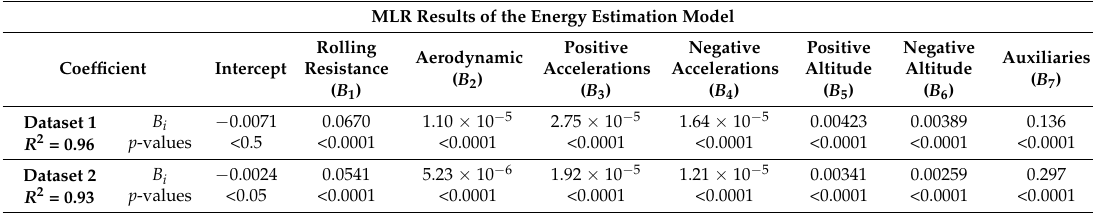
Table 2. Overview of the regression coefficients and p -values for energy estimation model based for Dataset 1 and Dataset